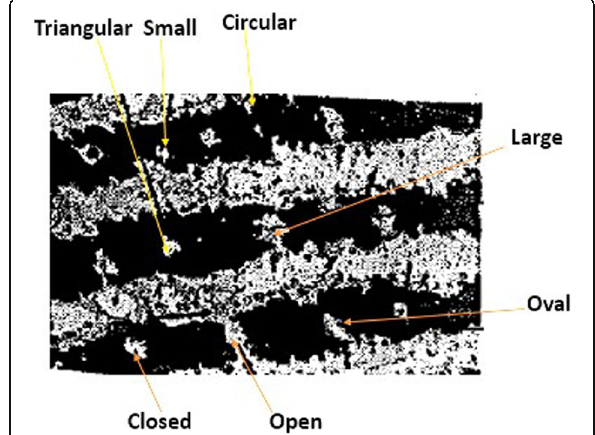
Fig. 1 The picture taken through stereo-microscope using a digital micro camera showing individual types of pores in a rolled impression of an individual on the flowing friction ridge of an